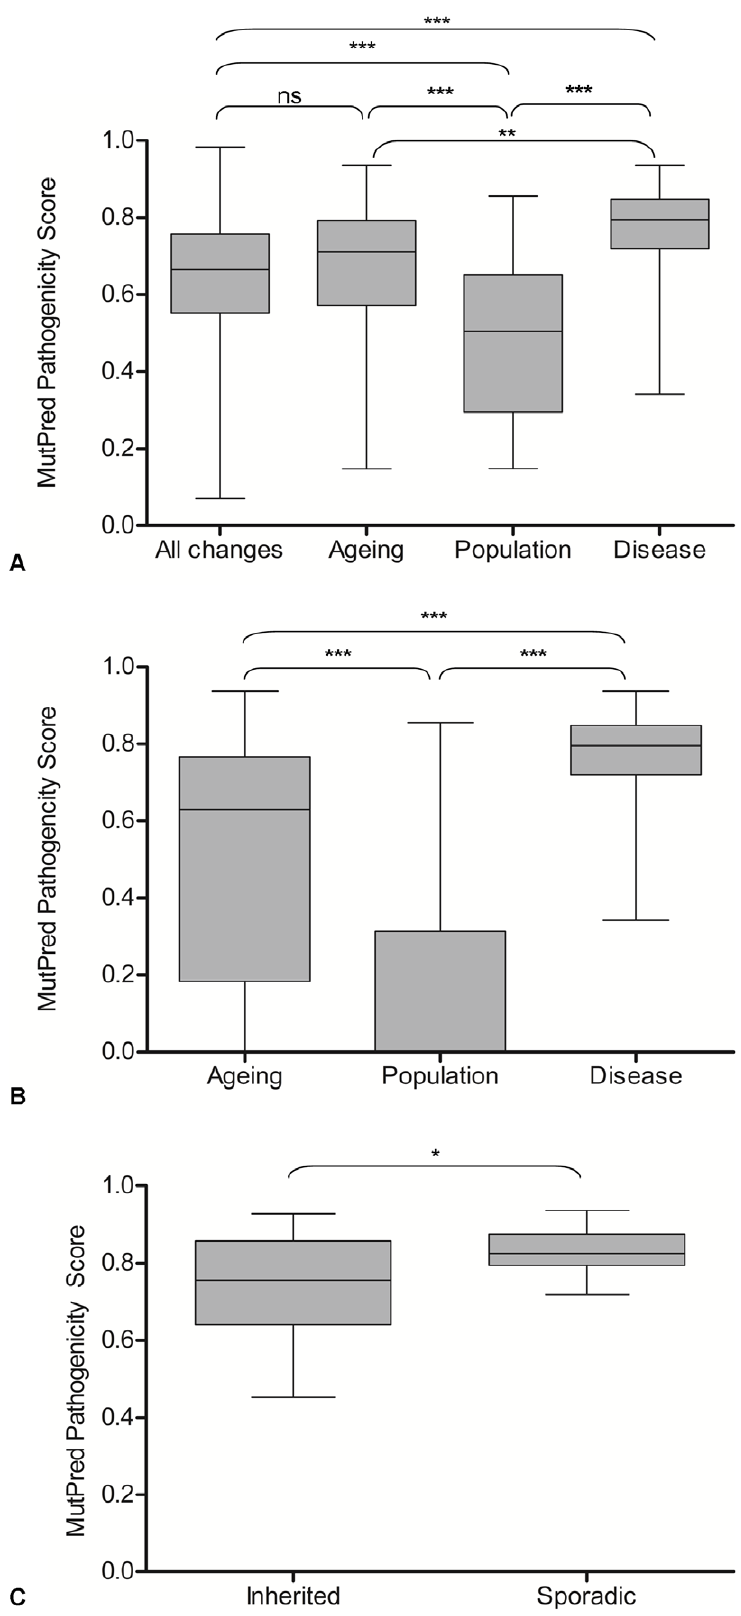
Figure 3. MutPred pathogenicity scores of mtDNA mutations in ageing, populations, disease, and all possible mtDNA mutations. A: The distribution of pathogenicity scores in ageing, populations, disease and all possible mutations. Results of Wilcoxon rank sum analysis are shown.